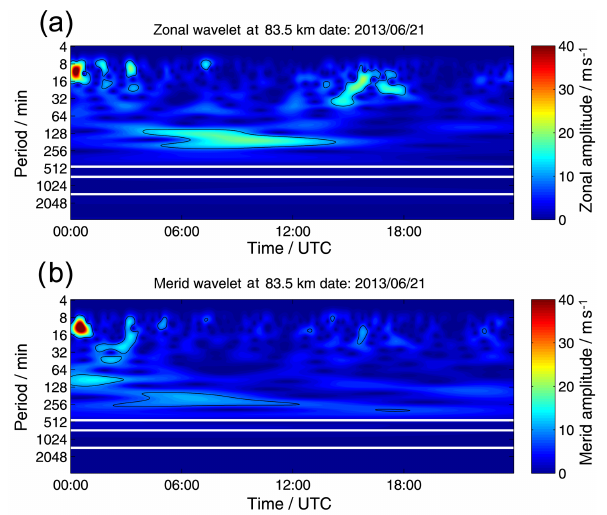
Figure 6. Wavelet spectra of the zonal and meridional wind using the MAARSY wind measurements after the diurnal, semidiurnal, and terdiurnal tide was